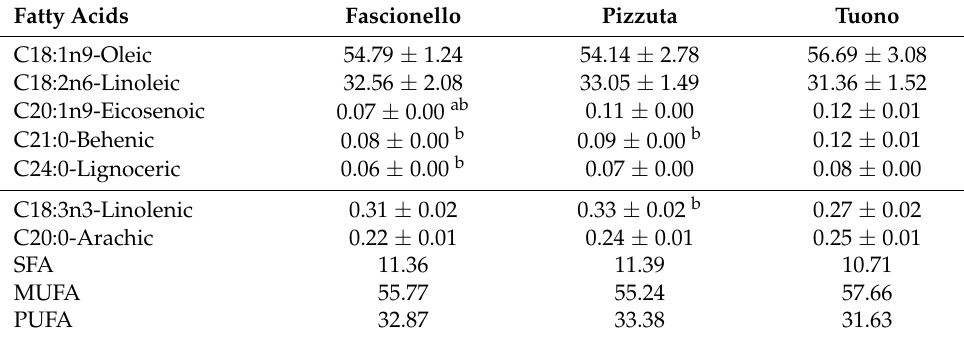
Figure 1. Agglomerative two-way hierarchical clustering analyses of the nutritional profiles of blanched skin (BS) samples belonging to the different producers of Fascionello (F), Pizzuta (P), and Tuono (T) cultivars.